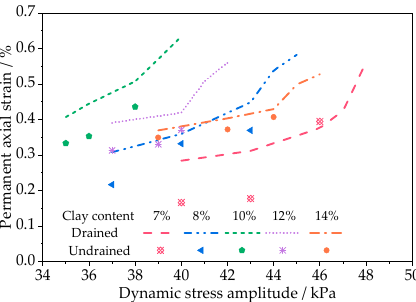
Figure 8. The relationship between permanent axial strain at 10,000 cycles and dynamic amplitude under different fine particle contents and drainage conditions.